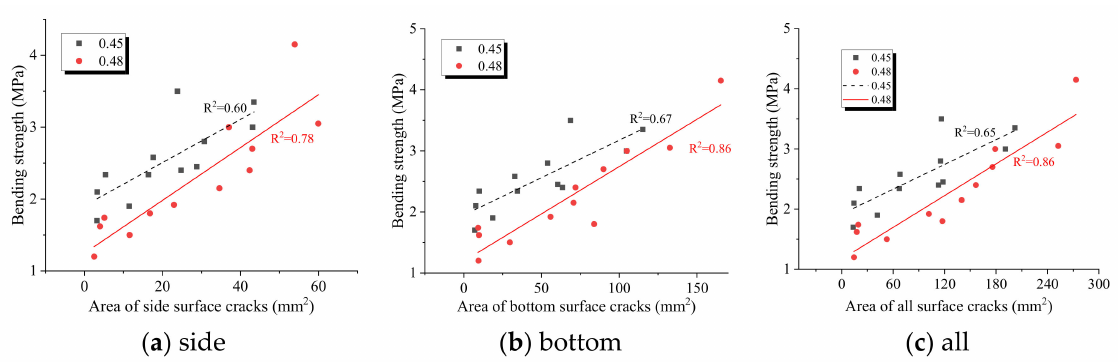
Figure 14. Relationship between bending strength and crack